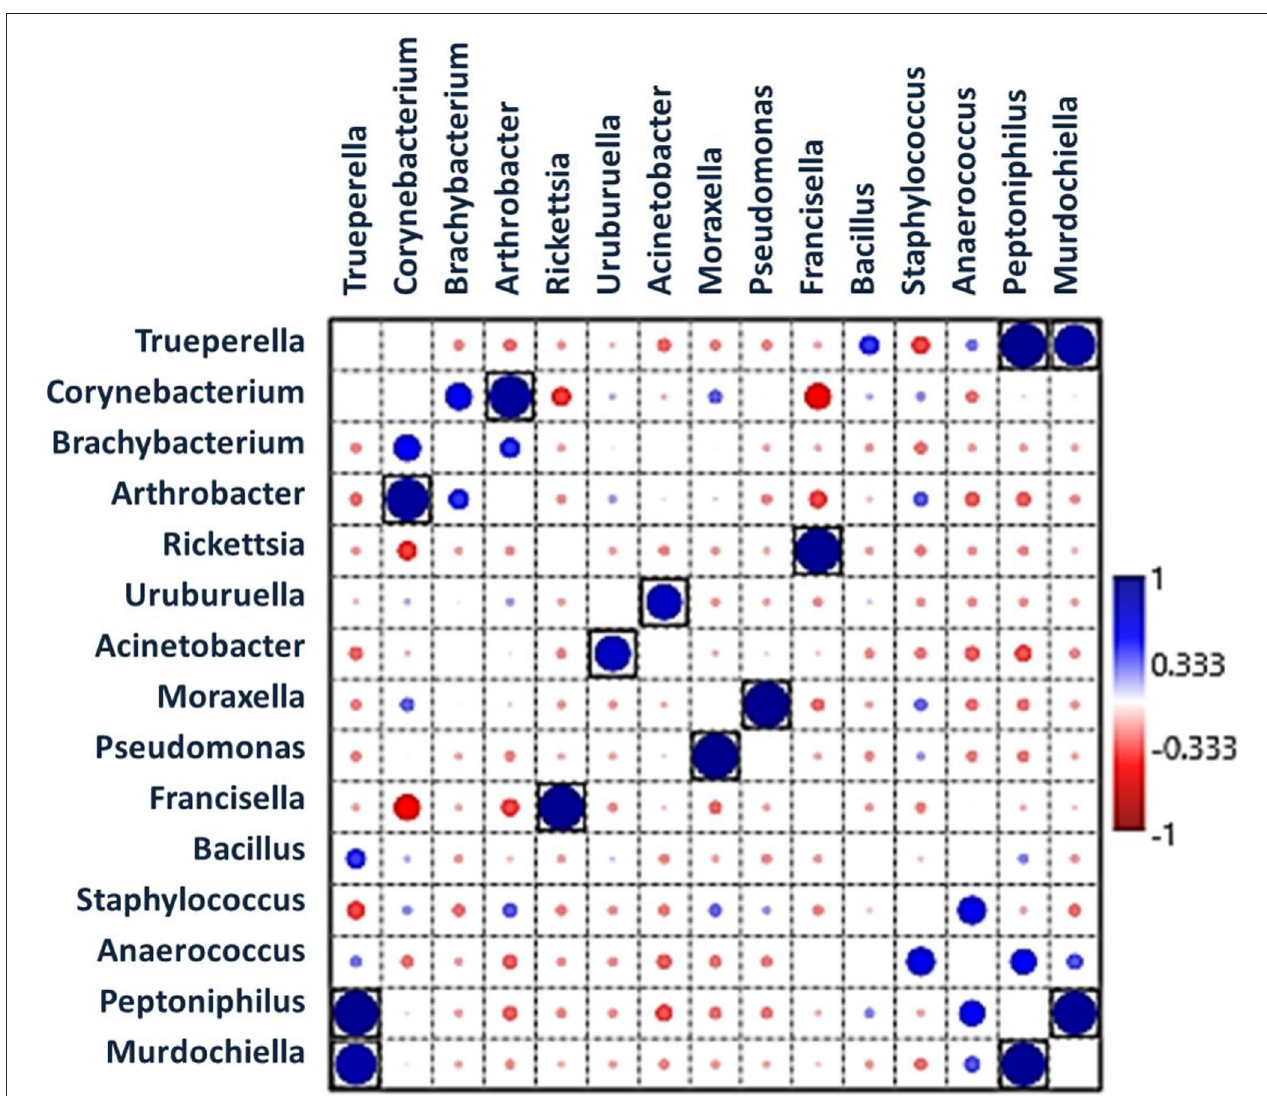
FIGURE 5 | Pearson’s correlation coefficients indicate associations between bacterial genera showing significantly positive interactions (large dark blue circles) and negative interactions (red circles). Black boxes denote p <